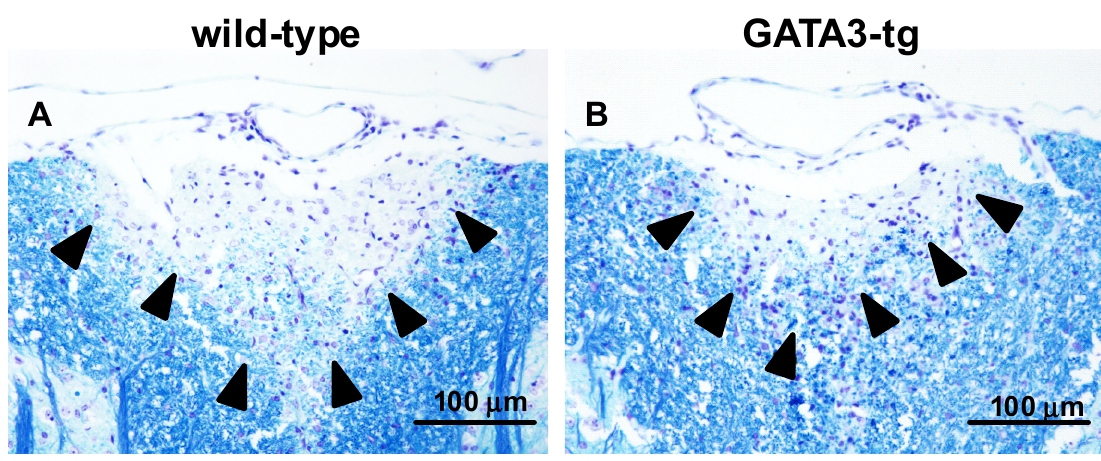
Figure 3. Demyelinating lesions in the spinal cord of wild-type ( A ) and GATA3-tg mice ( B ) during the late stage of EAE. Wild-type mice developed more severe demyelination, compared with GATA3-tg mice. Luxol fast blue stain. Magnification: